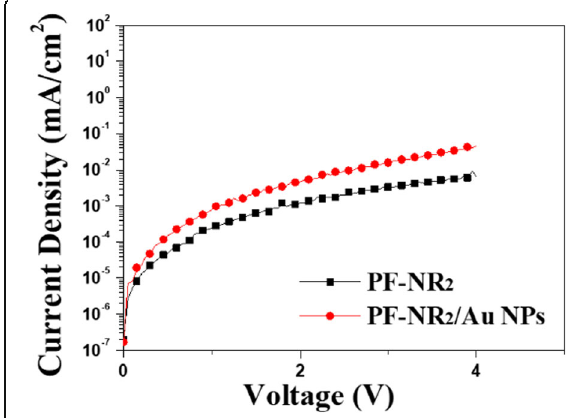
Fig. 5 The electron-only devices ITO/ZnO (30 nm)/PF-NR 2 (5 nm, with and without Au NPs)/P-PPV (80 nm)/CsF (1.5 nm)/Al (120 nm)